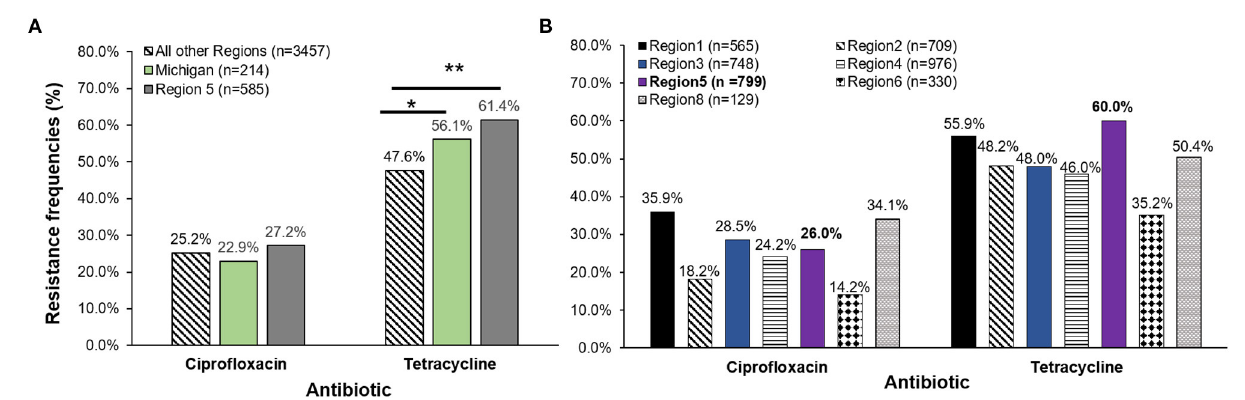
FIGURE 3 | (A) Antibiotic resistance frequencies of Campylobacter jejuni strains recovered from four Michigan hospitals ( n = 214) in 2011–2014 as compared to the National Antimicrobial Resistance Monitoring System (NARMS) data for the same time period. Michigan frequencies were compared to NARMS data from Region 5 acquired from Minnesota (representing Ohio, Indiana, Michigan, Illinois, Wisconsin, and Minnesota and 34 federally recognized tribes) and the total national data (excluding Region 5). (B) Michigan frequencies were added to Region 5 national data ( n = 585) leaving a total of 799 strains in the Midwest region for comparison to NARMS regions 1, 2, 3, 4, 6, and 8. * p ≤ 0.05, ** p ≤ 0.0001; χ 2 test. The 10 FoodNet sites representing Connecticut, Georgia, Maryland, Minnesota, New Mexico, Oregon, Tennessee, California, Colorado, and New York send data captured by the state public health laboratories to NARMS to represent the different regions. Data from Region 1 (Connecticut, Maine, Massachusetts, New Hampshire, Rhode Island, and Vermont), Region 2 (New Jersey, New York, Puerto Rico, and the Virgin Islands), Region 3 (Delaware, District of Columbia, Maryland, Pennsylvania, Virginia, and West Virginia), Region 4 (Alabama, Florida, Georgia, Kentucky, Mississippi, North Carolina, South Carolina, and Tennessee), Region 6 (Arkansas, Louisiana, New Mexico, Oklahoma, and Texas), and Region 8 (Colorado, Montana, North Dakota, South Dakota, Utah and Wyoming) were included in the analysis. Regions 7, 9, and 10 did not have data available for Campylobacter jejuni from 2011 to 2014 for